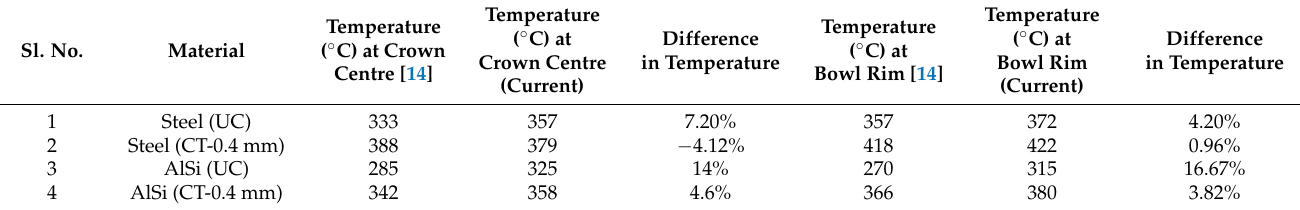
Table 3. Details of FEA model